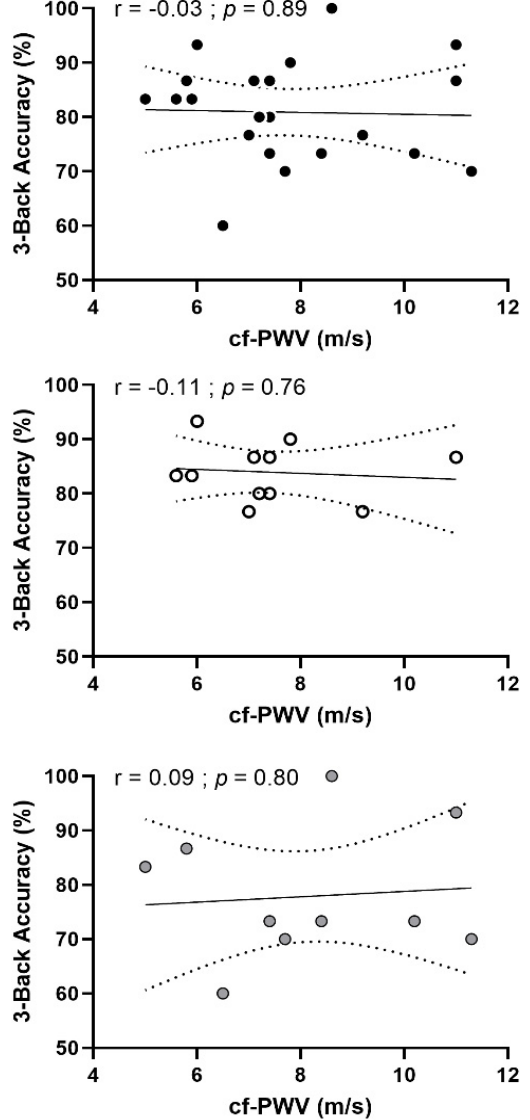
Figure 3. Relationship between 3-Back accuracy and cf-PWV in pre- and post-menopausal females. Top panel: pre-menopausal (n = 13) and post-menopausal (n = 10) females combined. Middle panel: pre-menopausal females only. Bottom panel: post-menopausal females only. The r and p values are for a Pearson correlation analysis.